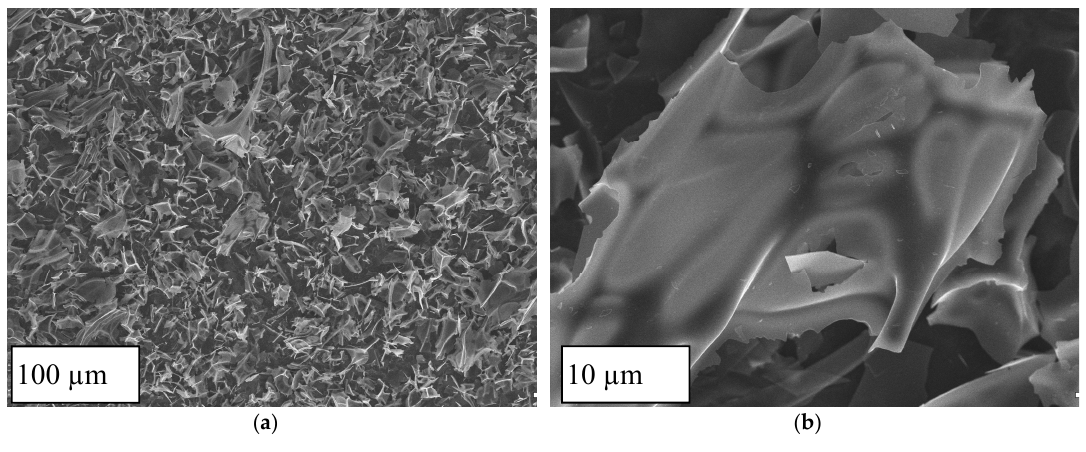
Figure 1. SEM images of rice starch ( a ) 100 μ m, ( b ) 10 μ m .